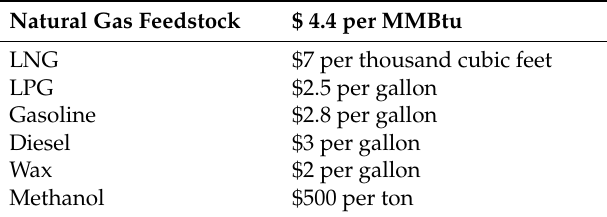
Table 2. Economic Data [38].